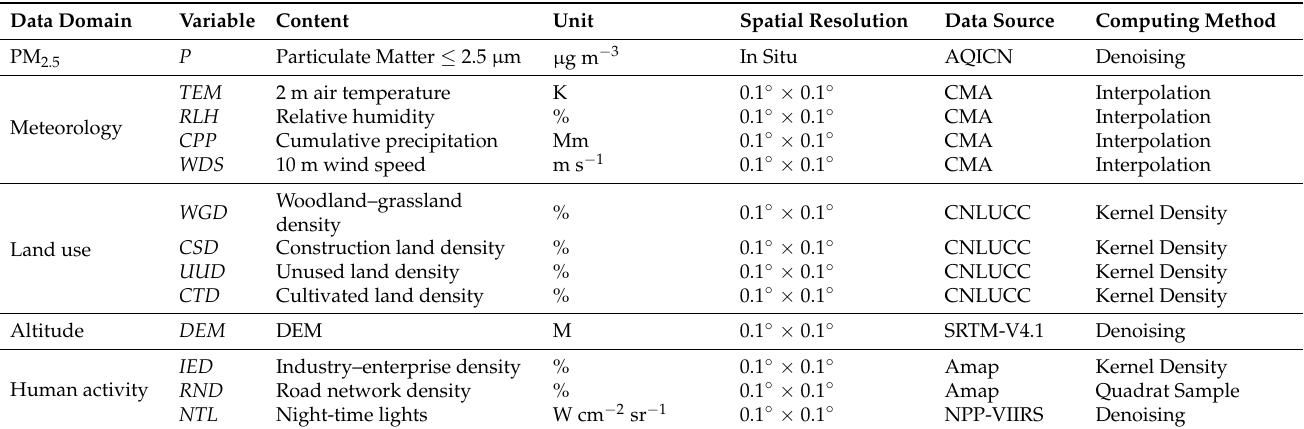
Table 1. Description of the data sources used in the study.